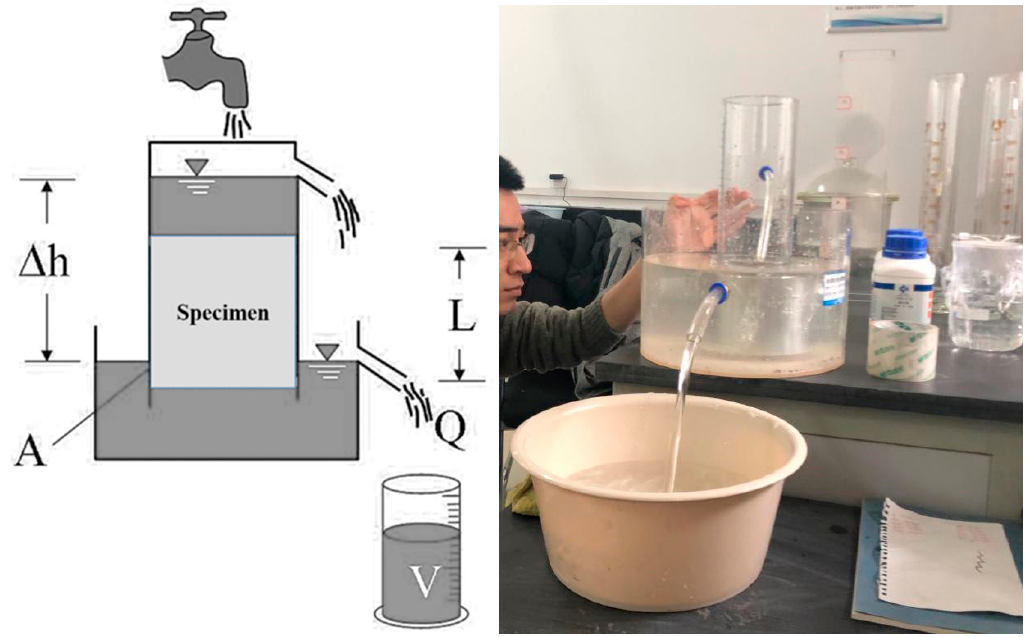
Figure 4. Constant falling-head permeability setup.